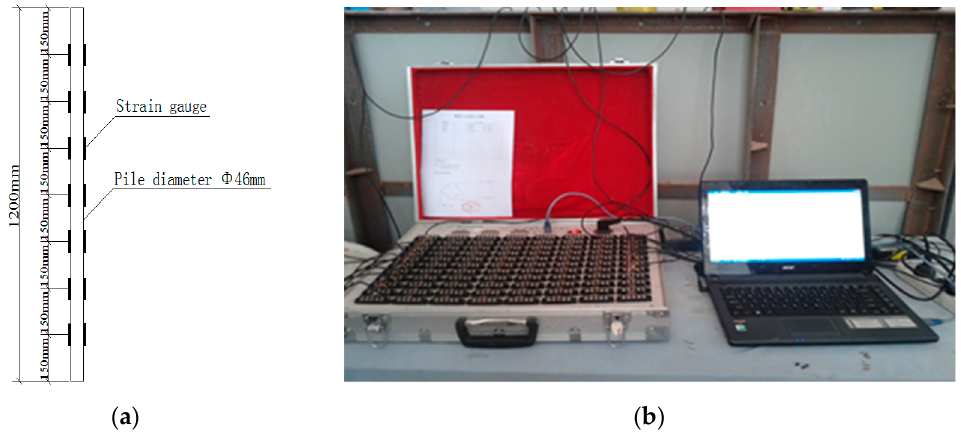
Figure 1. Strain monitoring of piles: ( a ) location of strain gauges; ( b ) multi-point static strain gauges (model:CM2B).